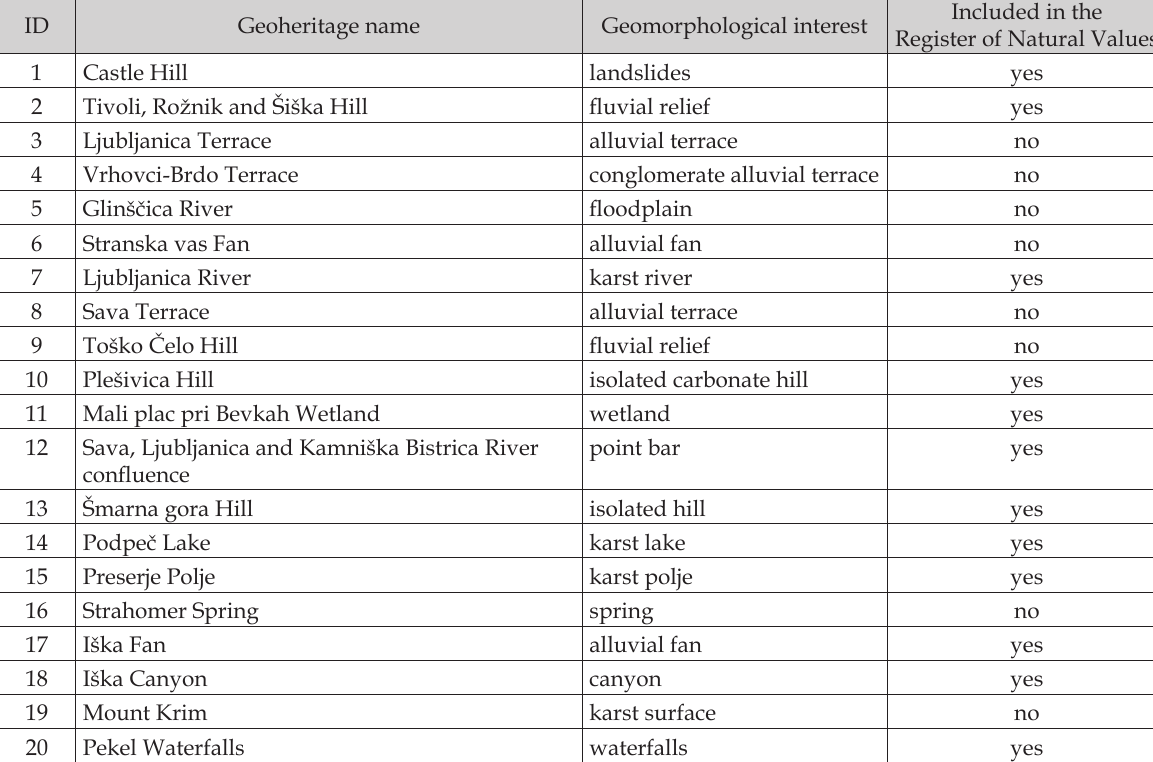
Table 1. List of 20 geosites in Ljubljana and its